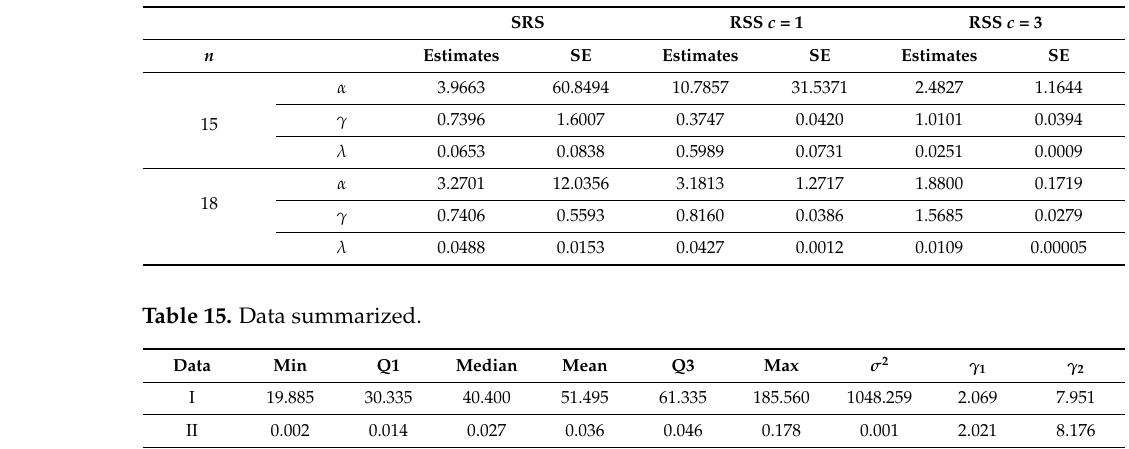
Table 14. MLE for the SRS and RSS of the COVID-19 data.